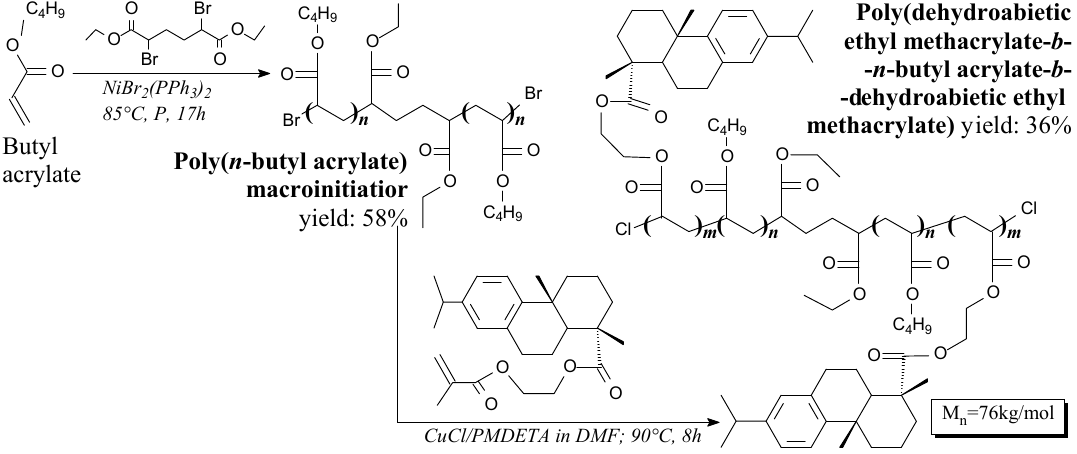
Scheme 56. Synthesis of rosin-based triblock